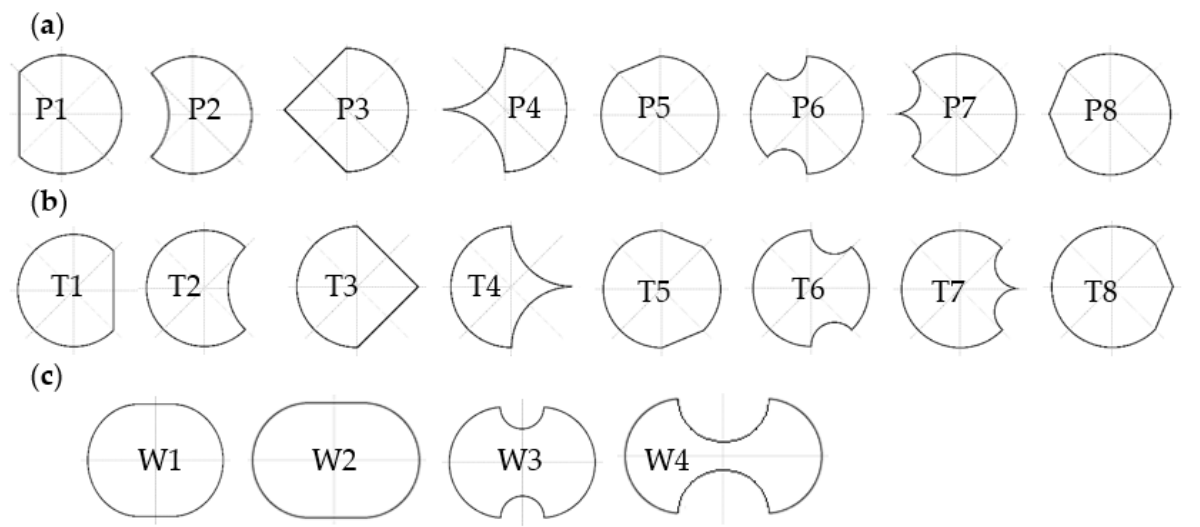
Figure 3. Shapes resulting from ( a ) rake surface modification ( b ) runoff surface modification ( c ) oval.